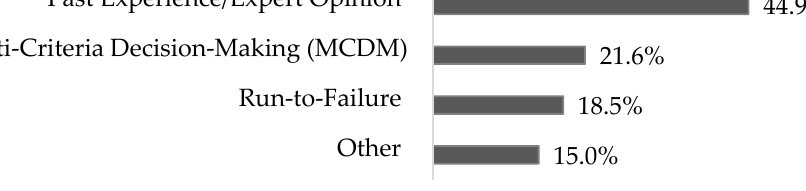
Figure 6. Distribution of decision-making practices in building maintenance.